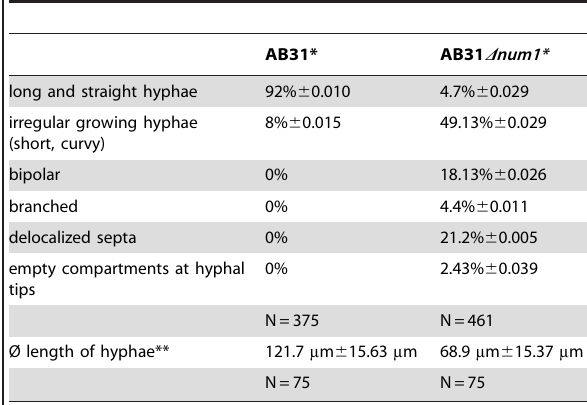
Table 1. Quantification of phenotypes in AB31 and AB31 D num1 12 hours after the induction of the bE/bW-